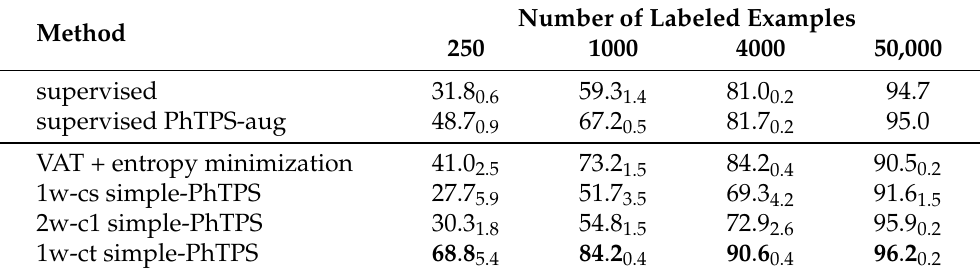
Table 6. Classification accuracy [%] on CIFAR-10 test with WRN-28-2. We compare two supervised approaches (top), VAT with entropy minimization [4] (middle), and two-way and one-way consistency with our perturbations (bottom three rows). We report means and standard deviations of 5 runs. The label “supervised PhTPS-aug” denotes the supervised training, where half of each mini-batch is perturbed with